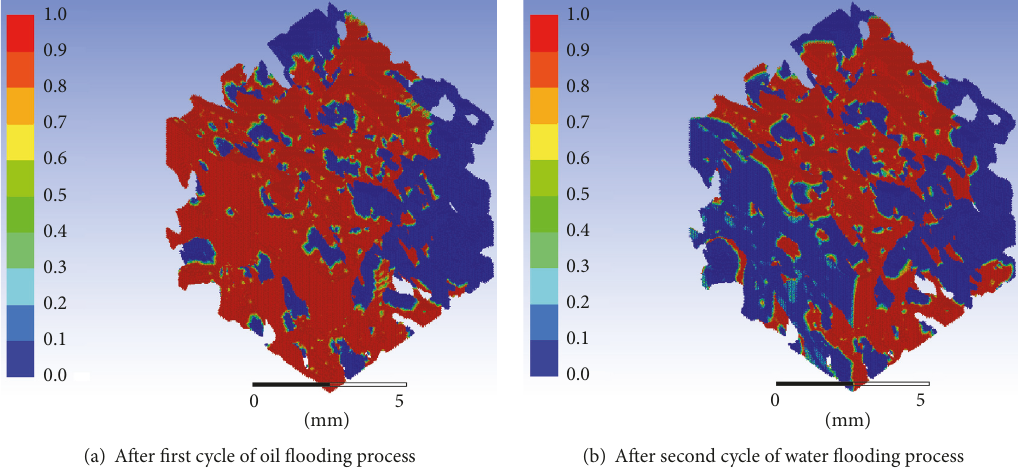
Figure 9: Oil volume fraction of MS1 after oil flooding and water flooding process; the red parts represent the oil phase.